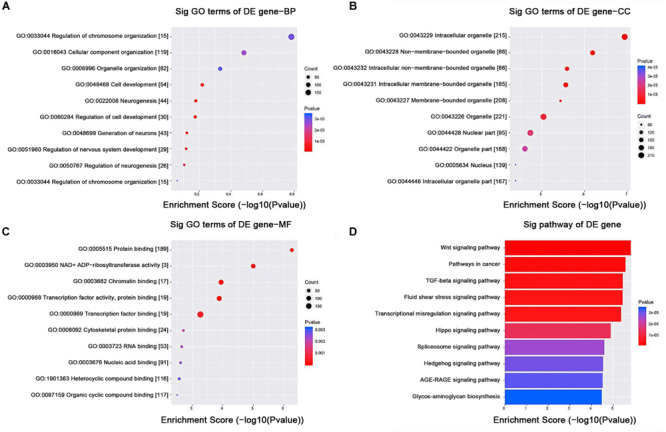
GO and KEGG pathway analysis. (A–C) GO annotation of targeted mRNAs with the top 10 enrichment scores for biological process, cellular component, and molecular function, respectively. (D) The top 10 enriched KEGG pathways. GO, gene ontology; KEGG, Kyoto Encyclopedia of Genes and Genomes.